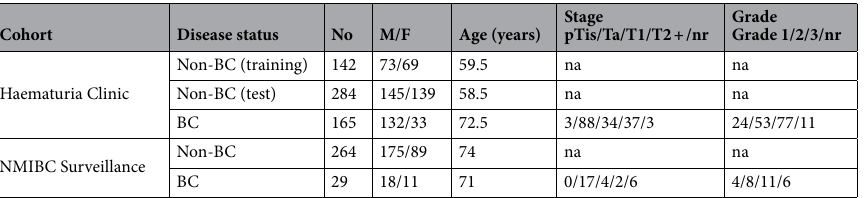
Table 1. Patient characteristics. M = male, F = female, age = median age, stage/grade: nr = not recorded.